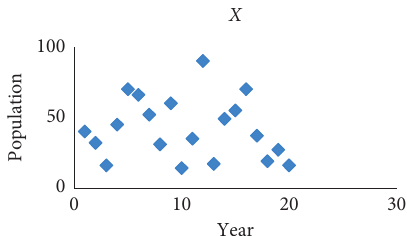
Figure 3: Topological space X consisting of 2-dimensional surfaces.